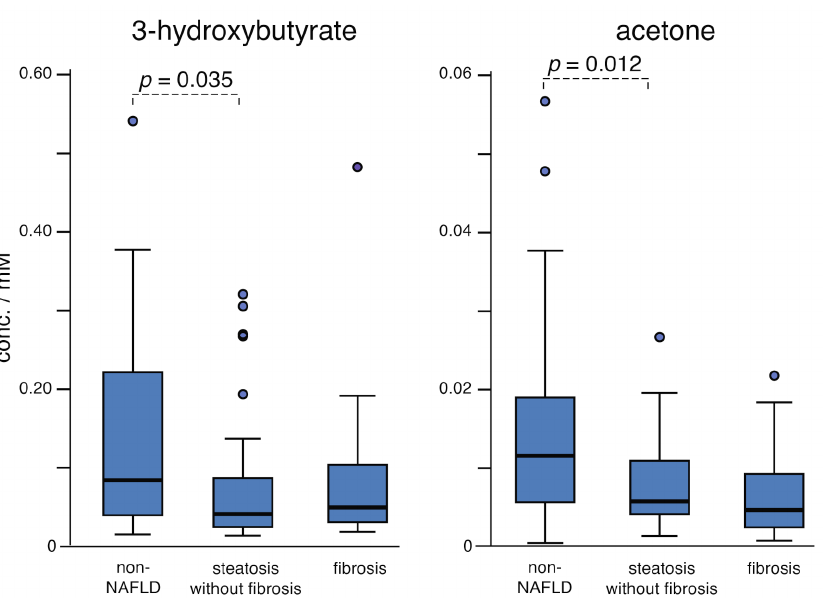
Figure 1. Boxplots illustrate decreasing ketone bodies in the steatosis group that are also depressed in the fibrosis group. Acetone may be influenced by the extraction, but its trend here is similar to that of 3-hydroxybutyrate, where each decreased by about two-fold across the groups. Acetoacetate is un- reliable in these data but is explored in Figure S2 (Supporting Information). Multiply concentrations by 2 for the serum